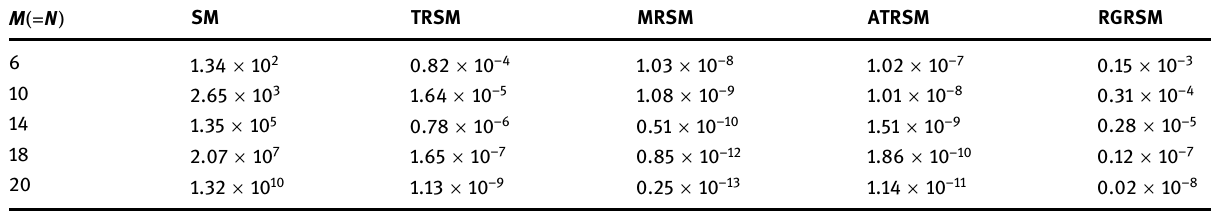
Table 2: The errors E ∞ ‖ ‖ obtained for Example ( 4.1 ) with RSMs and SM, when